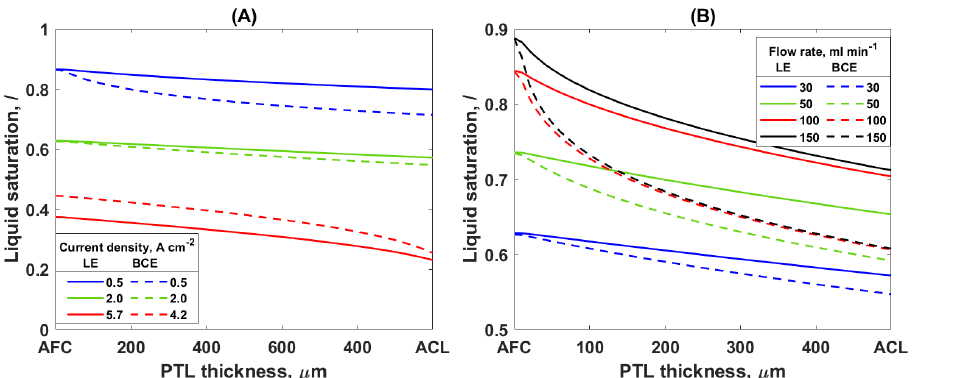
Figure 3. Liquid saturation through the PTL2 thickness ( A ) for different values of current density at inlet flow rate 30 mL min − 1 and ( B ) for different values of inlet water flow rate at current density 2 A cm − 2 ; solid lines—LE simulation, dashed lines—BCE